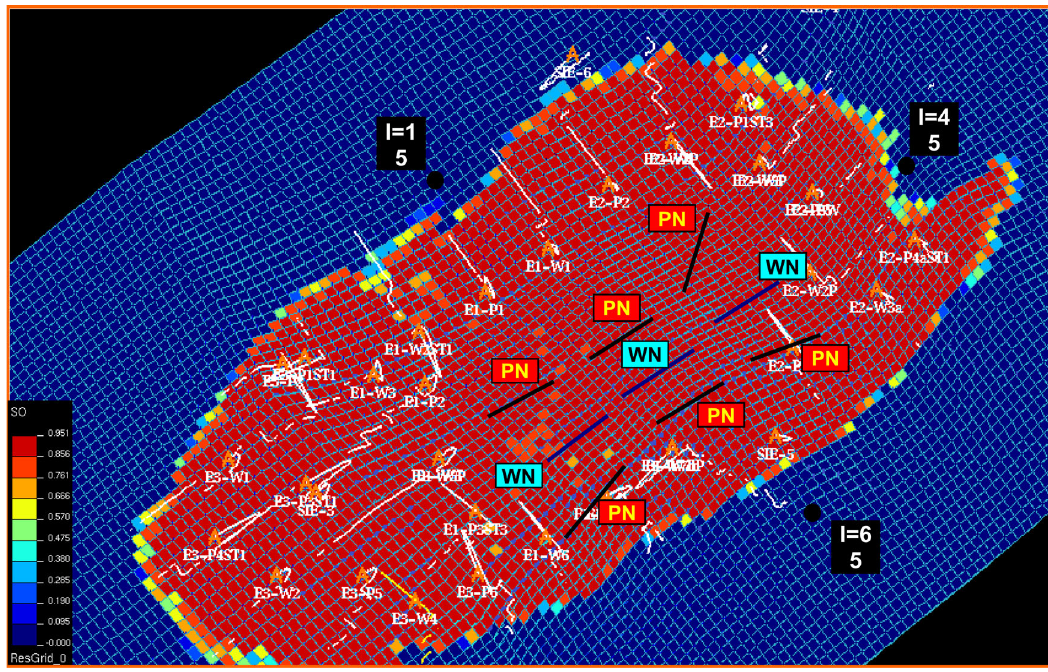
Fig. 1 Location of the wells in the